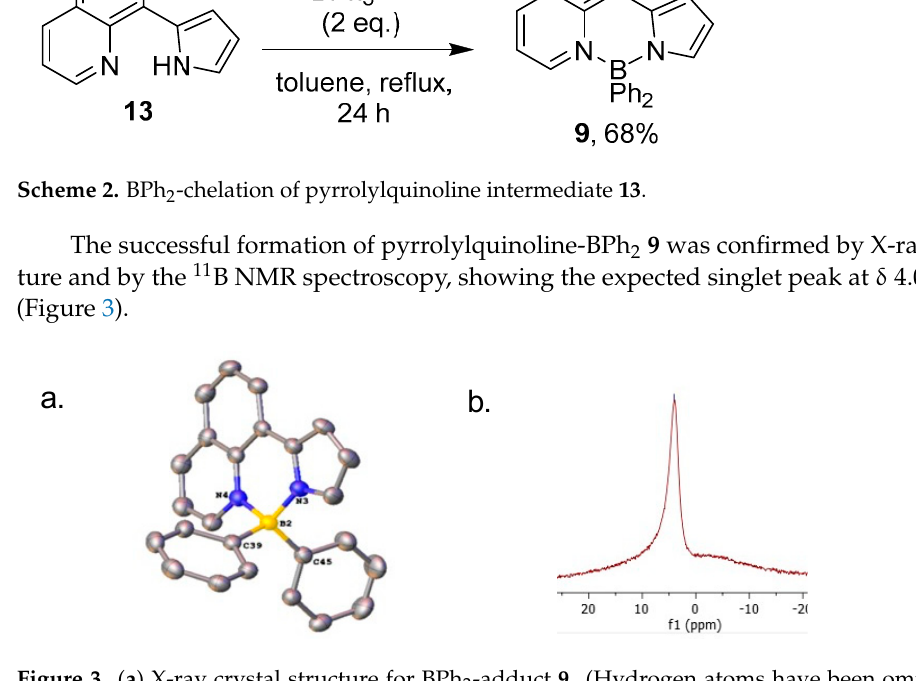
Figure 3. ( a ) X-ray crystal structure for BPh 2 -adduct 9 . (Hydrogen atoms have been omitted for clarity). ( b ) 11 B NMR spectrum for 9 (96 MHz, CDCl 3 ).